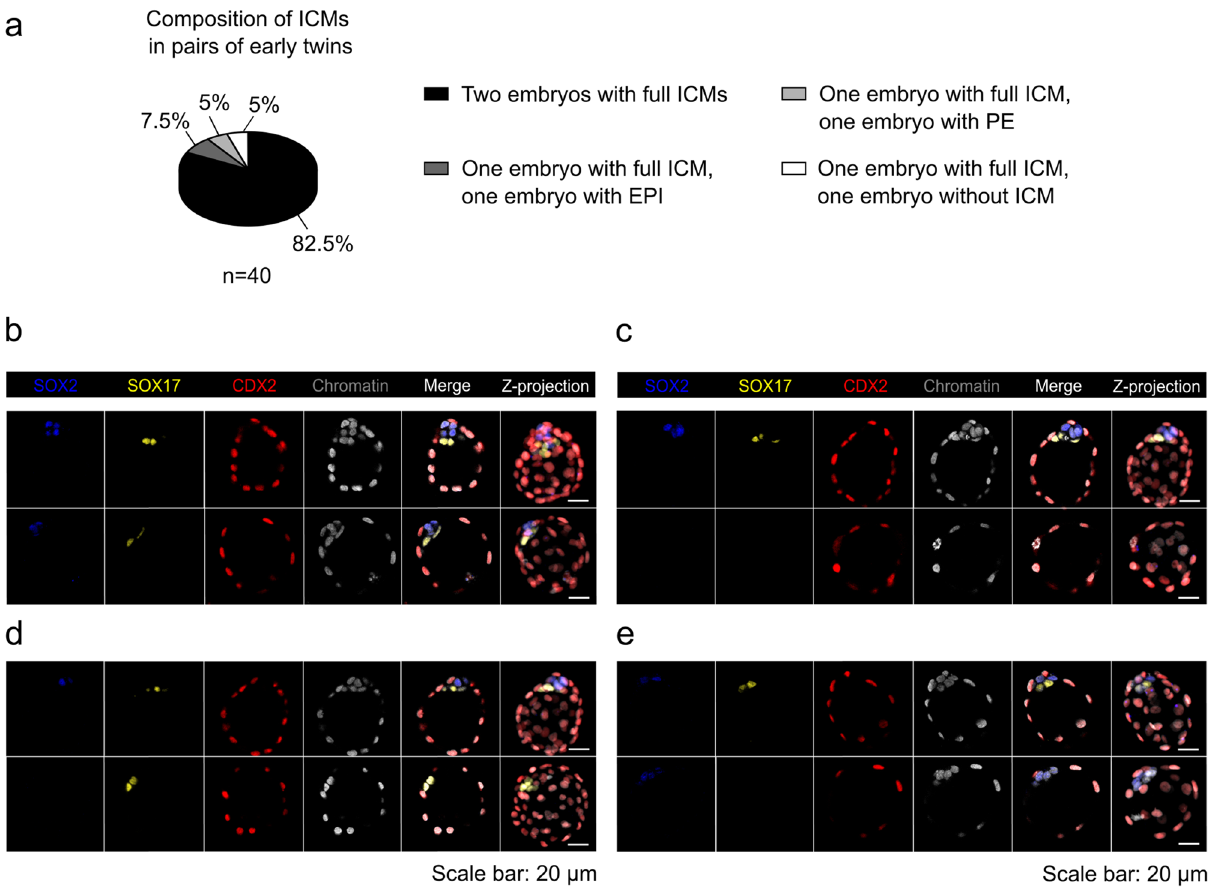
Figure 2. Potency of pairs of early twin blastocysts to generate inner cells. ( a ) Composition of ICMs in pairs of early twin blastocysts. ( b , c , d , and e ) Immunodetection of SOX2 (blue), SOX17 (yellow), and CDX2 (red) in representative twin blastocysts. Chromatin (white) was labeled with chromomycin A 3 . The last panel corresponds to the average intensity projections of Z-stack images. Scale bar: 20 µm. A pair in which both embryos had ICMs consisting of EPI and PE progenitors is shown in ( b ). A pair in which one embryo created a complete ICM and the other developed into a trophoblastic vesicle is presented in ( c ). The pairs in which one embryo created a complete ICM and the other only PE or EPI progenitors are shown in ( d ) and ( e